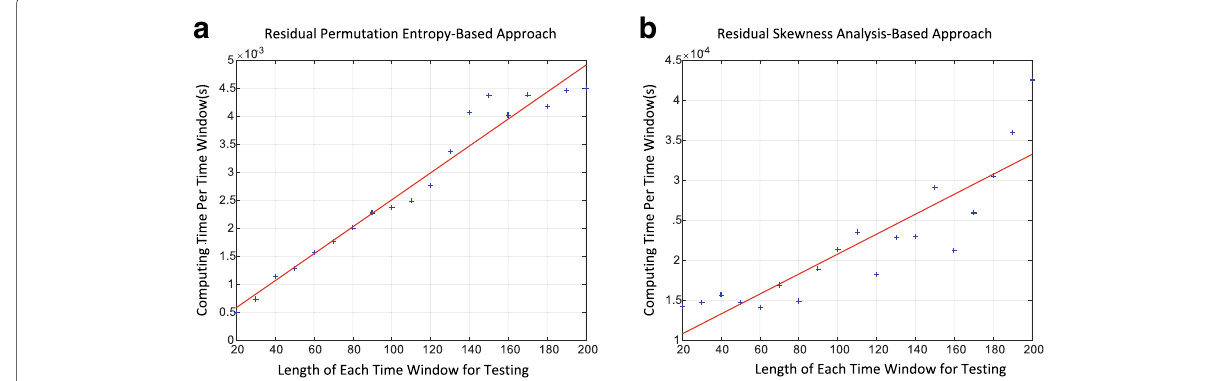
Fig. 11 Detection time comparison of two different approaches, ( a ) the residual permutation entropy-based approach and ( b ) the residual skewness analysis-based approach. The blue points are observed computing time and the red lines are fitted lines for the blue